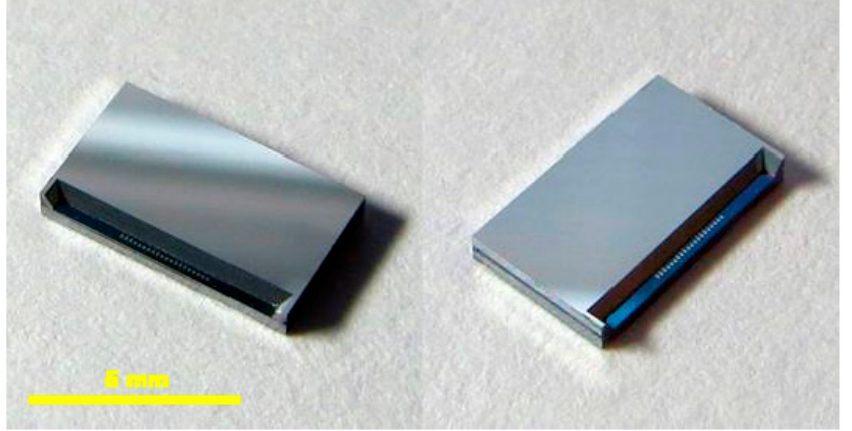
Figure 8. Close-up views of the naked sensor dies.